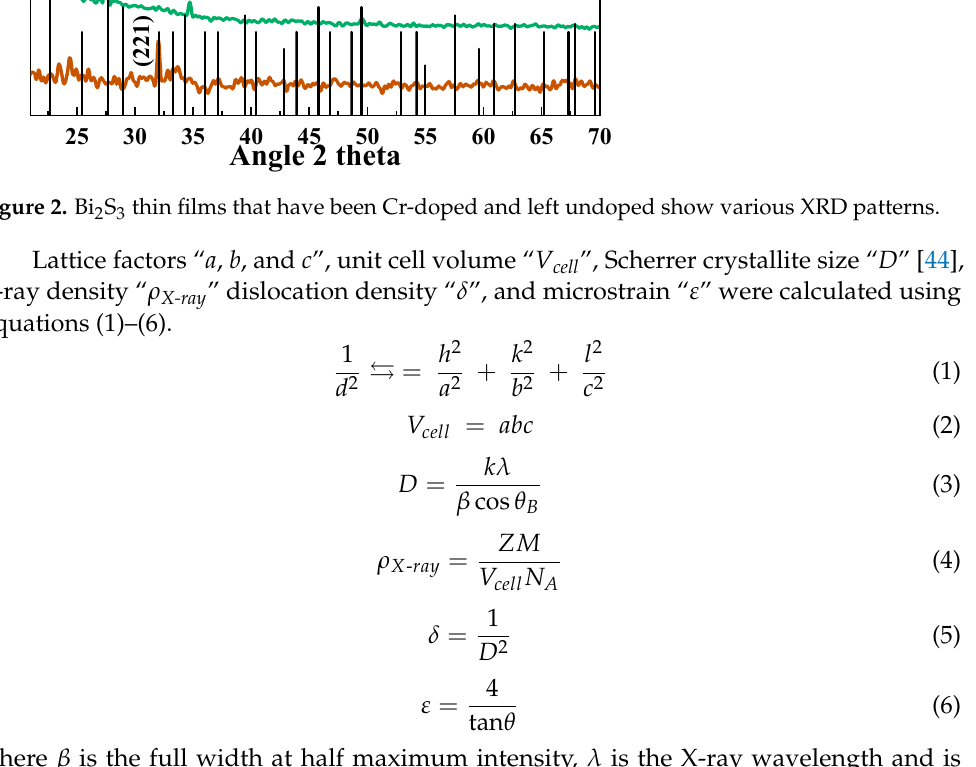
Table 1. Crystallographic parameters calculated from XRD data for thin